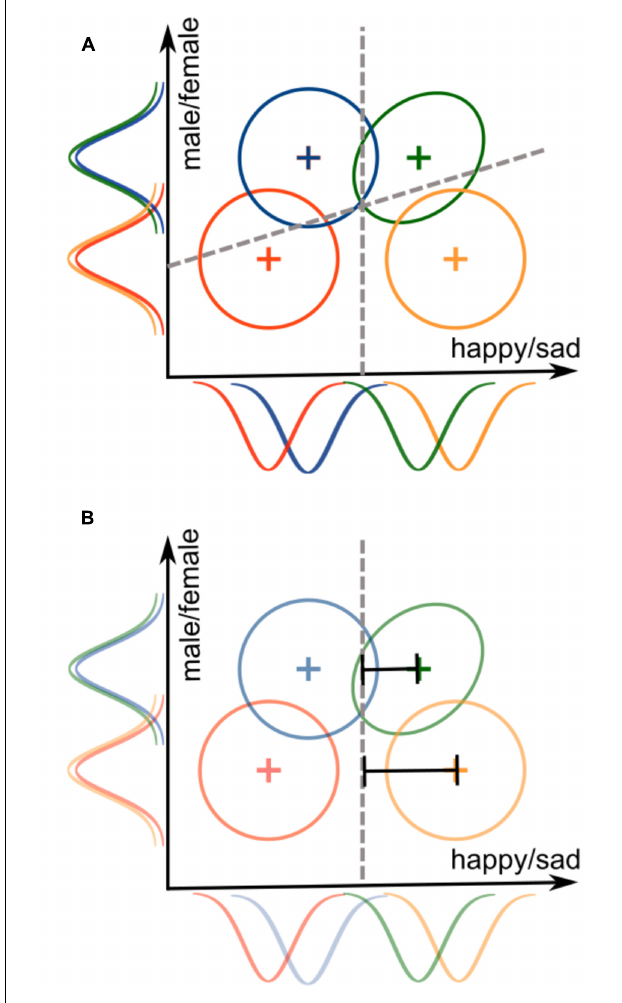
FIGURE 3 | Illustration of a General Recognition Theory (GRT) model for the (A) 2 × 2 identification task and the (B) 2 × 2 Garner filtering task. Both models use the exact same stimulus representations, but the decision bounds represent the different demands of the tasks. The identification task requires dividing the space into four response regions, one for each stimulus, whereas the Garner filtering task requires dividing the space into two regions, one for each level of the relevant